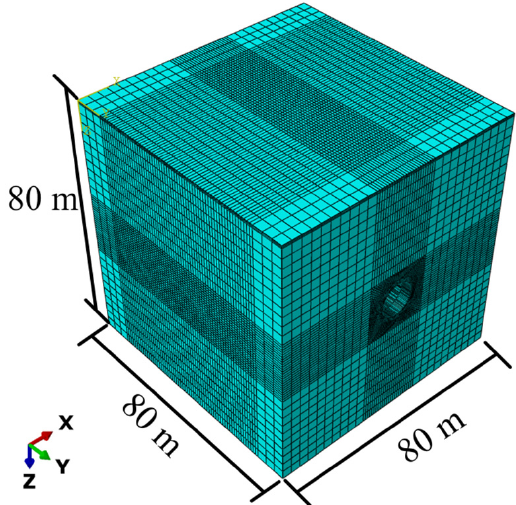
Figure 6. A schematic of the mesh division.